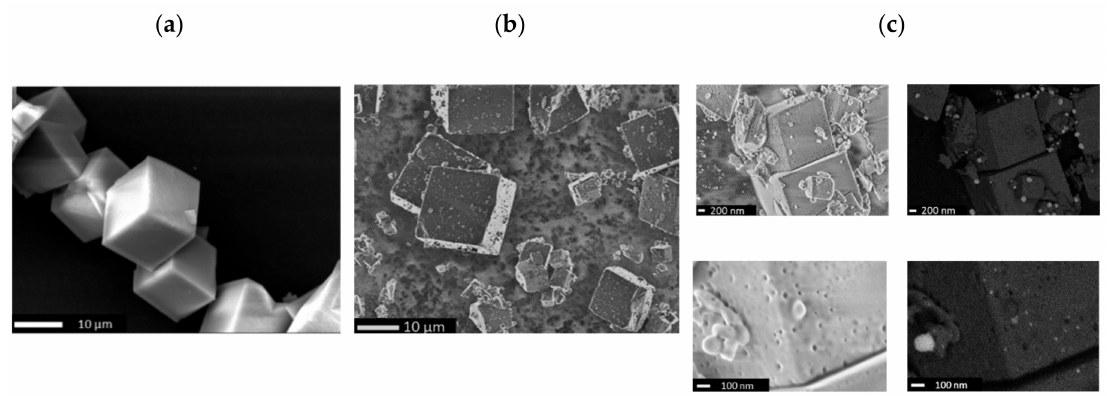
Figure 2. SEM images acquired for ( a ) parent zeolite H-SSZ-13, ( b ) Mo / H-SSZ-13 after calcination in air (700 ◦ C, 5 ◦ C / min, 30 min), and ( c ) comparison of secondary and backscattering electron images at di ff erent magnifications for calcined Mo /